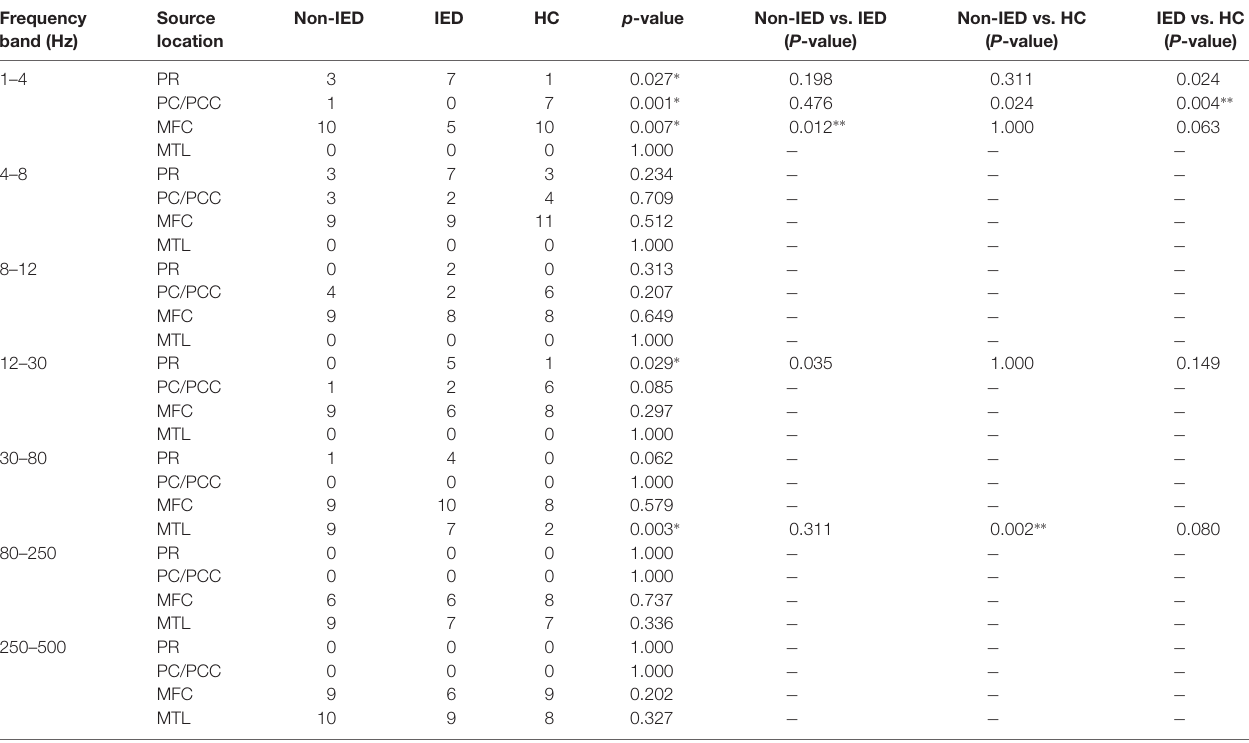
TABLE 2 | Predominant neuromagnetic activities in interictal epileptiform discharges (IED), non-IED and healthy controls (HC) group. Frequency Source Non-IED IED HC p -value Non-IED vs. IED Non-IED vs. HC IED vs. HC band (Hz) location